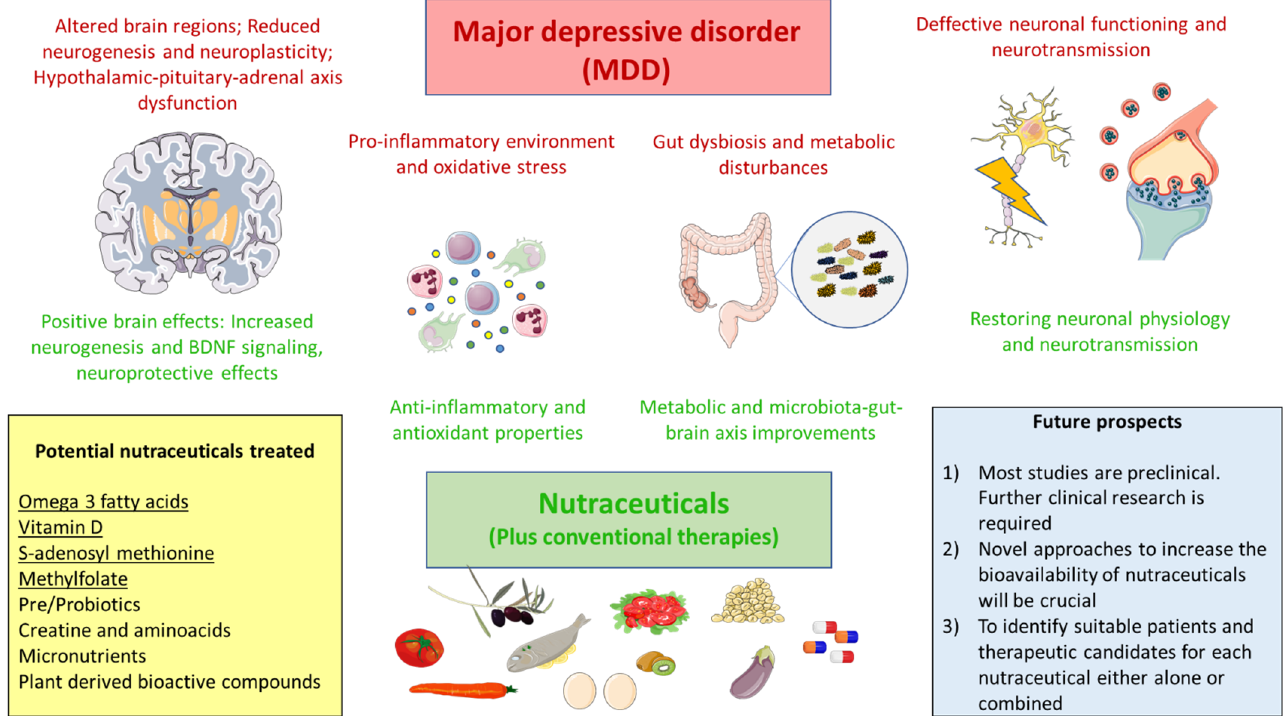
Figure 1. A Graphic summary of the ideas transmitted.